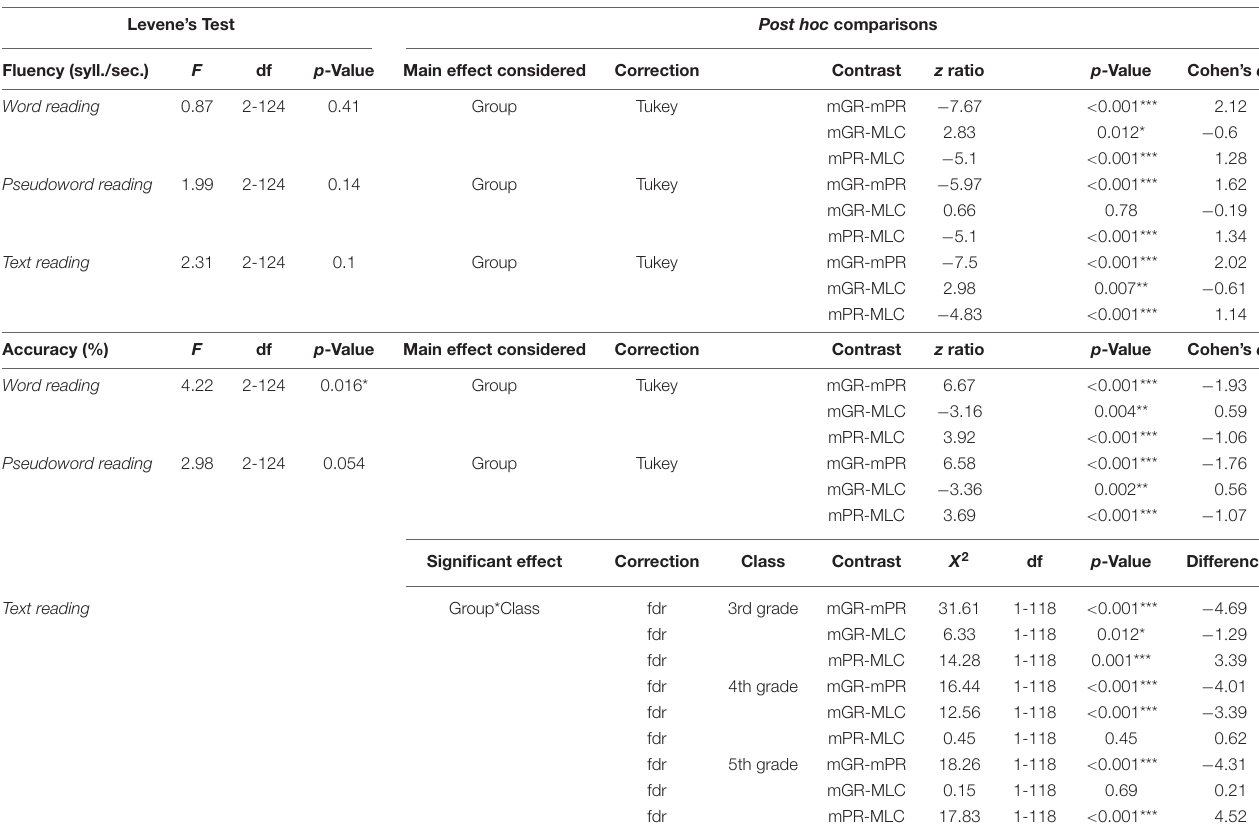
TABLE 4 | Results of the Leven’s Test and post hoc statistic comparisons run for exploring significant effects emerged from the GLMs run on reading measures. Levene’s Test Post hoc comparisons